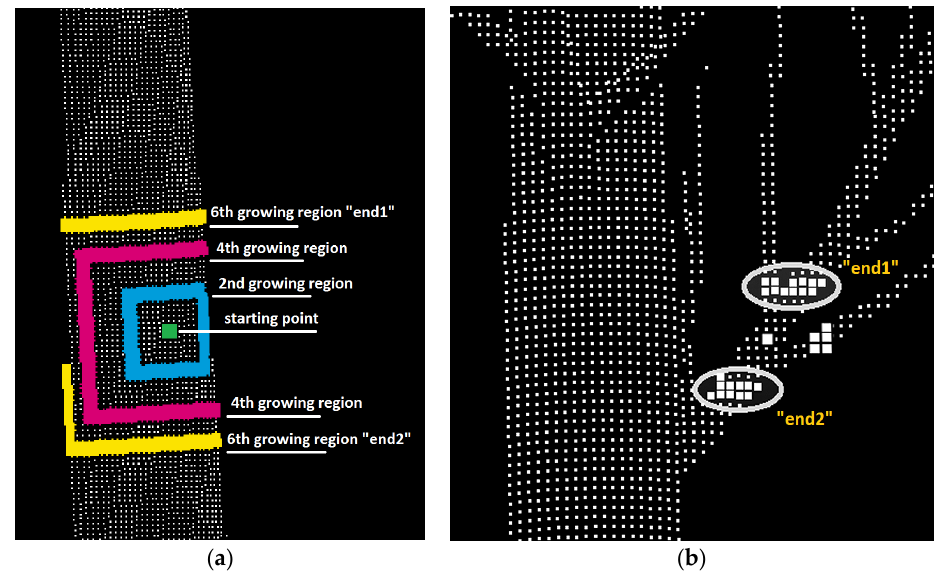
Figure 4. Region growing example. ( a ) The starting, 2nd, 4th, and 6th growing regions colored in green, blue, pink, and yellow, respectively; ( b ) “end 1” and “end 2” (circled) recognized from a growing region with four clusters.